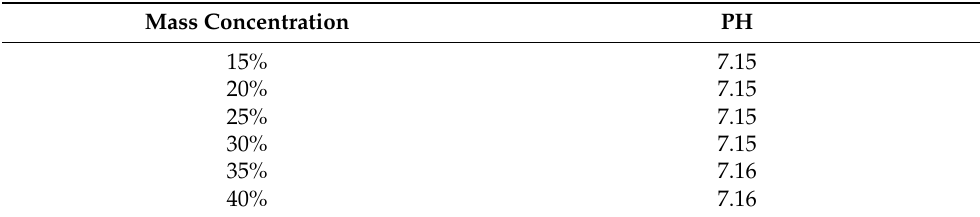
Table 5. PH value of tailing slurry with different concentrations.